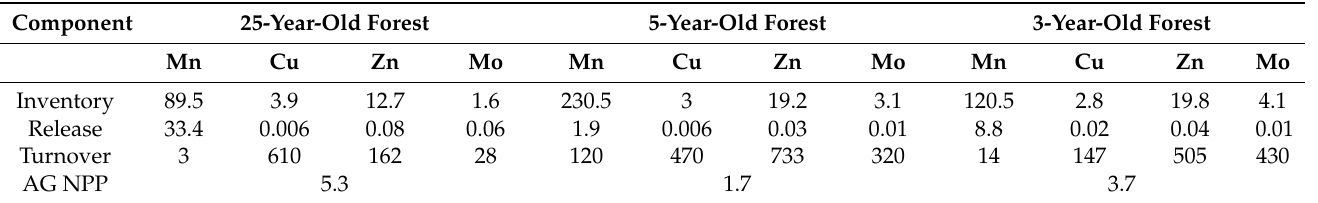
Table 5. Soil Mn, Cu, Zn, and Mo inventories (g m − 2 ), release rates (g m − 2 a − 1 ), and turnover times (a) in 25-, 5-, and 3-year old Rhizophora apiculata forests in southern Thailand. Soils were sampled to depth of maximum root penetration. AG NPP (kg C m − 2 a − 1 ) = aboveground net primary production. Source: [65].